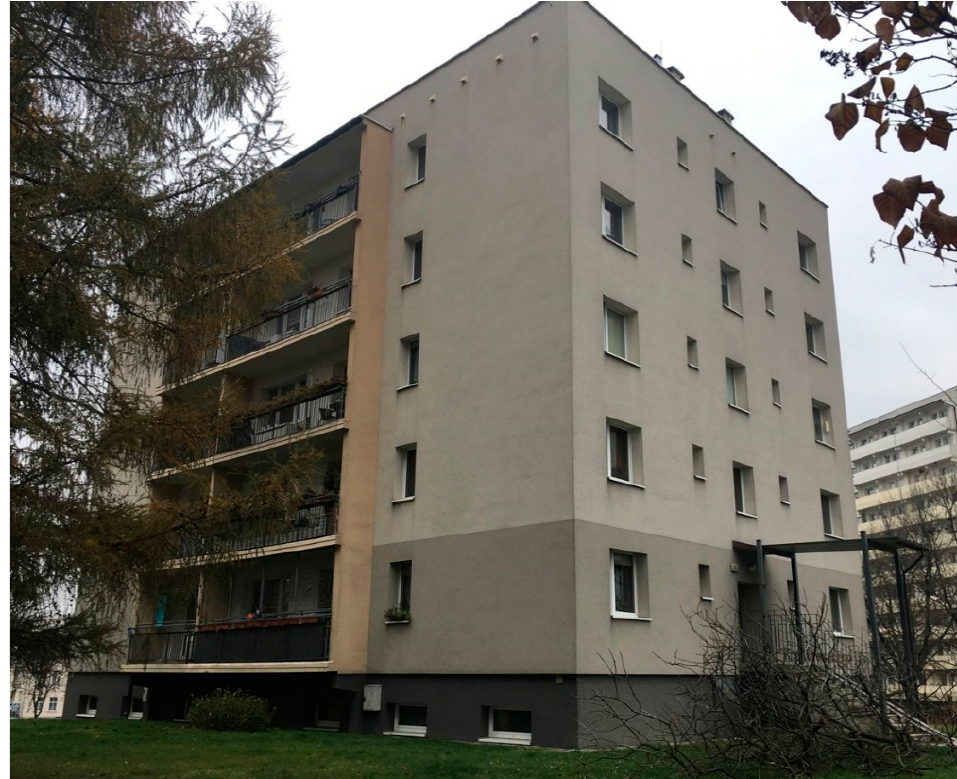
Figure 1. View of the analyzed building.